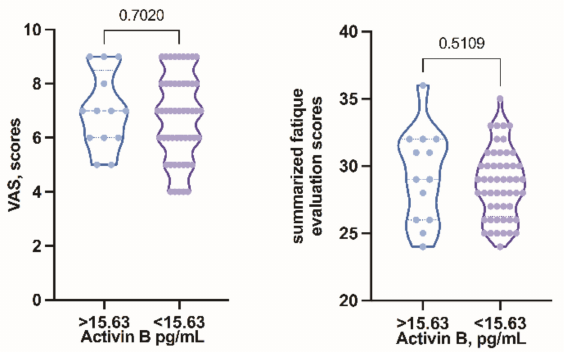
Figure 4. Symptom severity grading score compared in activin B positive and activin B negative groups.